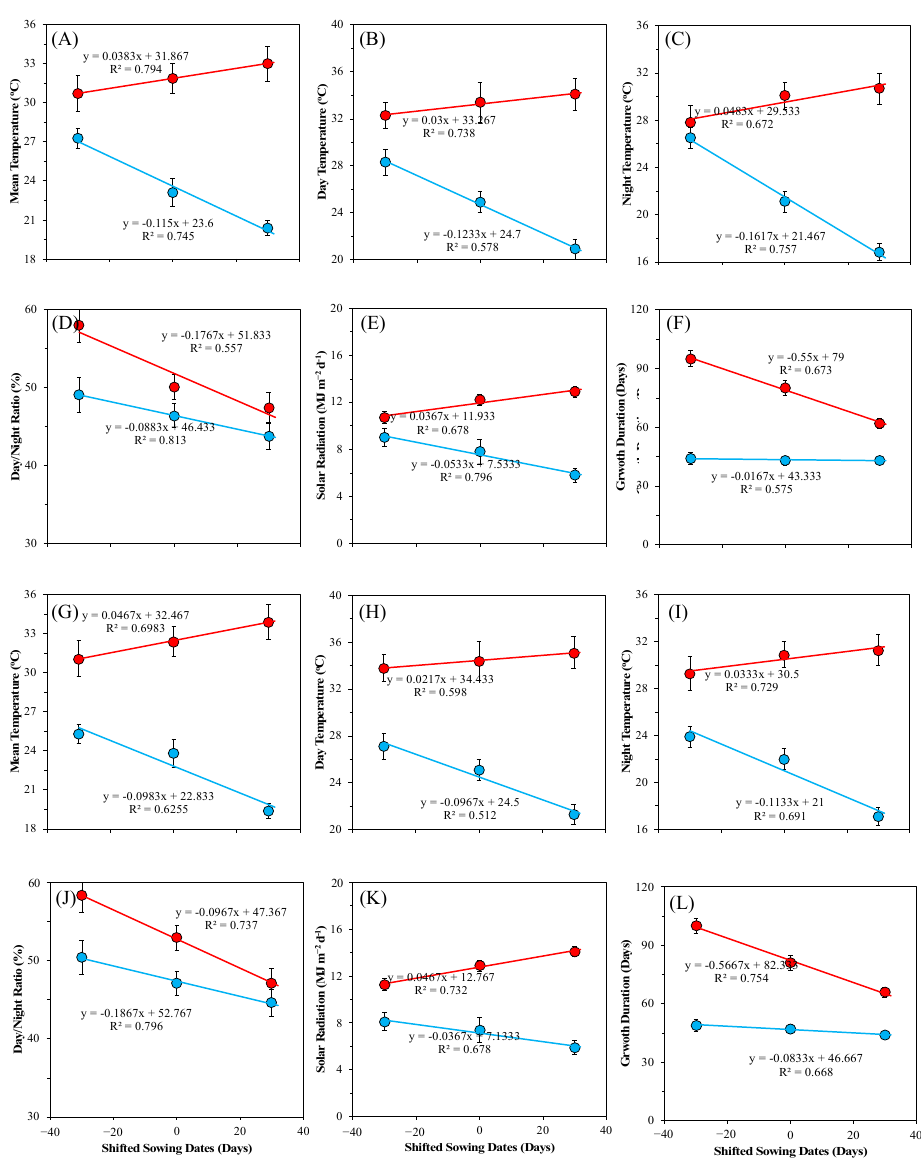
Figure 1. Environmental parameters and growth duration for different sowing dates before heading and after heading in 2019 ( A – F ) and 2020 ( G – L ). Note: Red dots in the plot indicated environmental parameters at before heading, blue dots in the plots indicated environmental parameters at after heading.